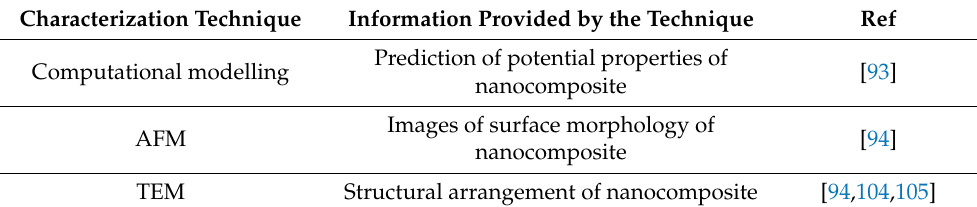
Table 5. Summary of characterization techniques for polymer